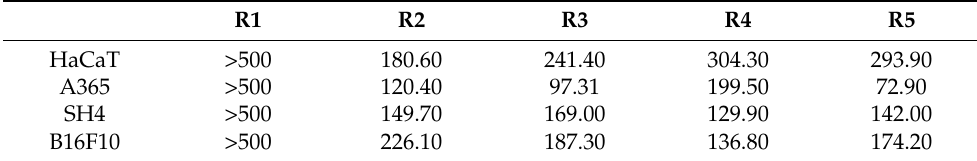
Table 3. Cytotoxicity of R1–R5 extracts from various parts of R. platyacantha (IC 50 in µ